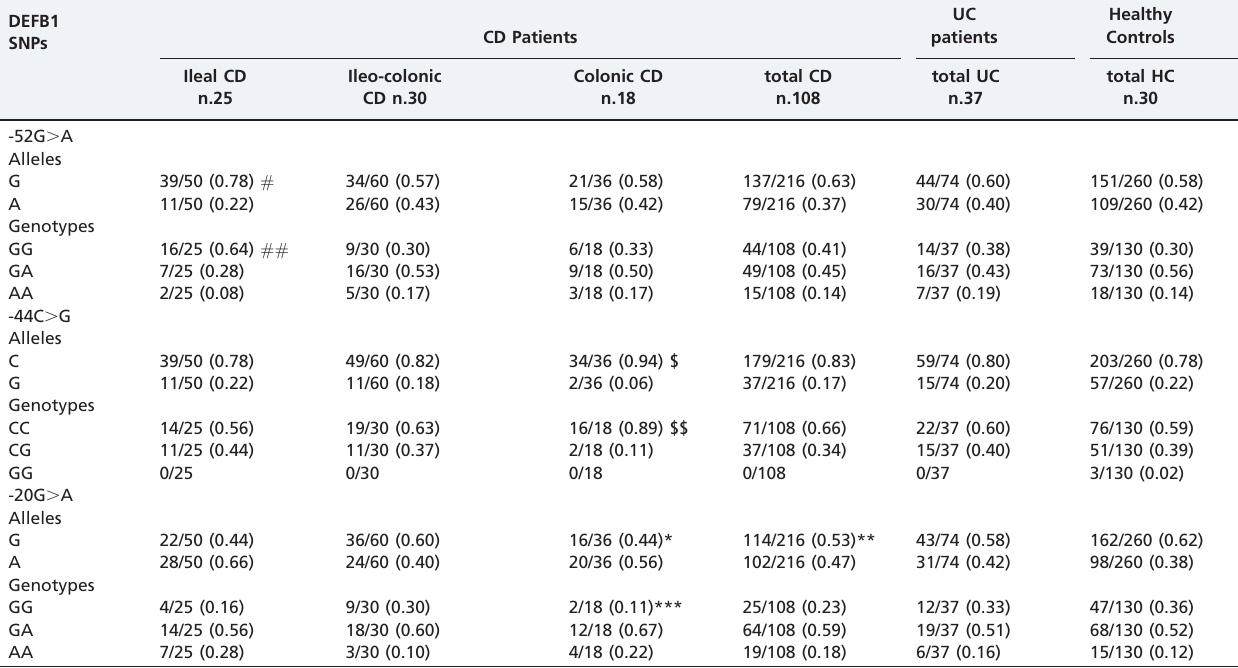
Table 1 - Allele and genotype count (and frequencies) of 5 9 UTR DEFB1 single-nucleotide polymorphisms in Crohn’s disease patients, ulcerative colitis patients and healthy controls. The Crohn’s disease patients are also stratified according to the anatomical localization of the disease. The p -values , 0.05 (uncorrected), odds ratios (ORs) and 95% CIs are also